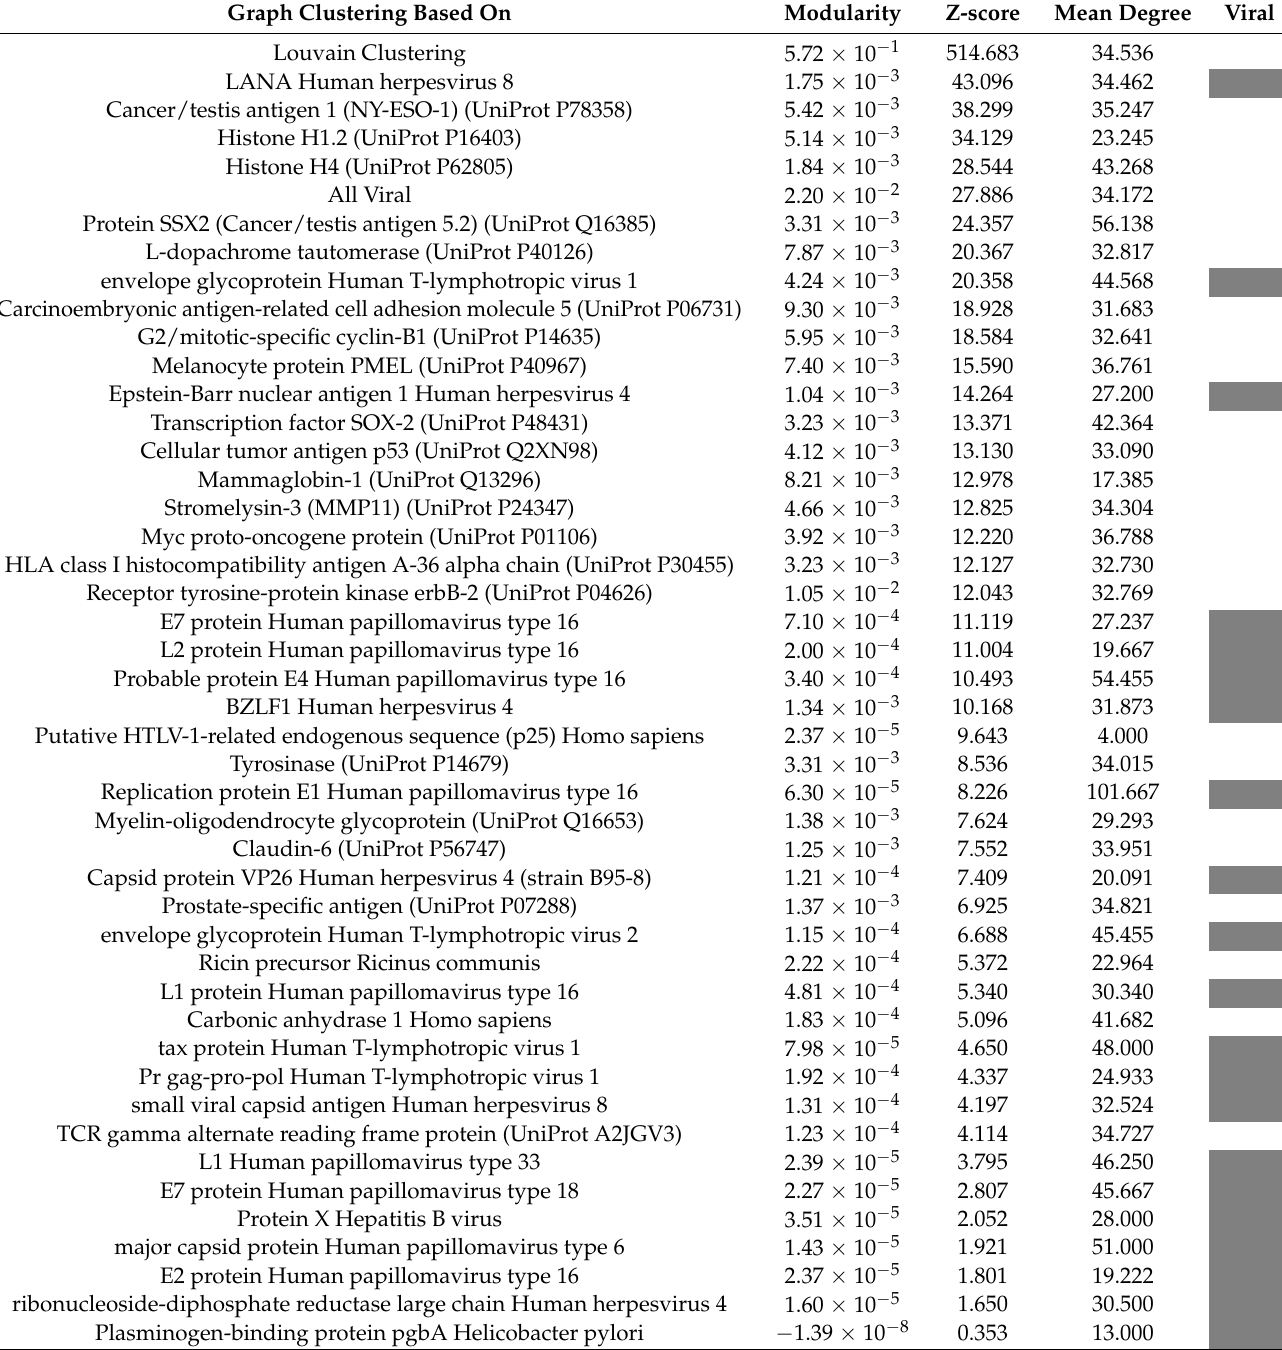
Table 1. Epitopic diversity measured by modularity of the reactivity graph. Each protein is isolated as a cluster of vertices compared to the rest of the graph. The modularity of this clustering is then compared to a bootstrapped distribution of the modularity of the same number of random vertices in this graph to calculate the z-score. The latter indicates the actual magnitude of the compactness of the cluster, meaning how closely related are the reactivity profiles of the linear epitopes of this protein. Although diverse, the collection of all viral epitopes studied showed high modularity compared to the self-antigen epitopes. Louvain clustering refers to the clustering of the whole graph in 15 clusters (Figure 7A). The column “Viral” indicates the viral proteins and epitopes by shading. Graph Clustering Based On Modularity Z-score Mean Degree